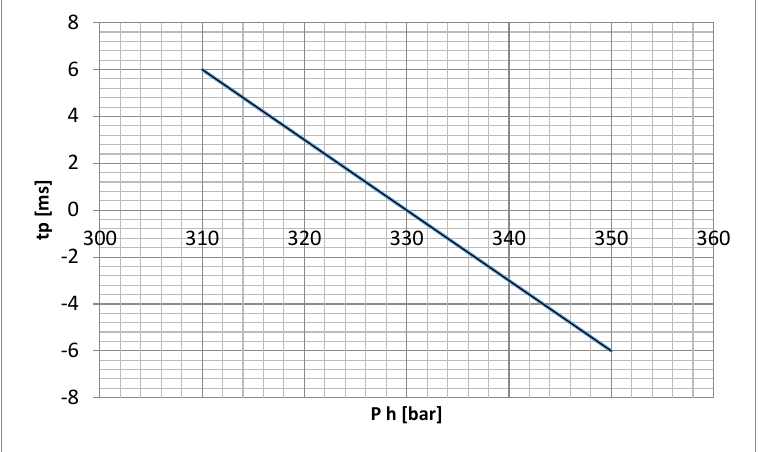
Figure 22 represents the dependency of parameter C Ph on the oil pressure on the connection of a circuit breaker.